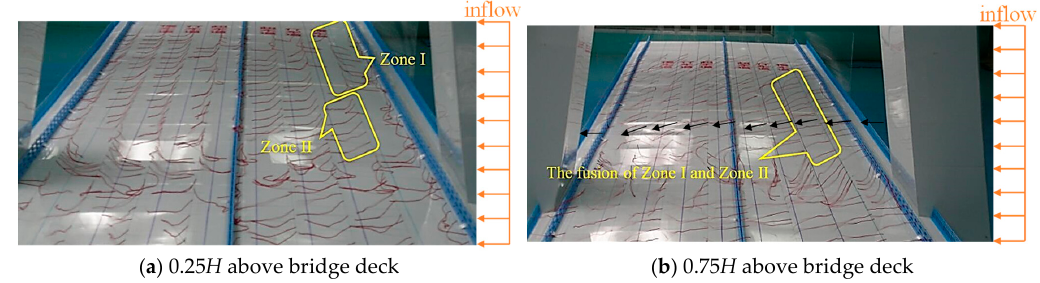
Figure 7. Flow field from experimental results (C1 condition).